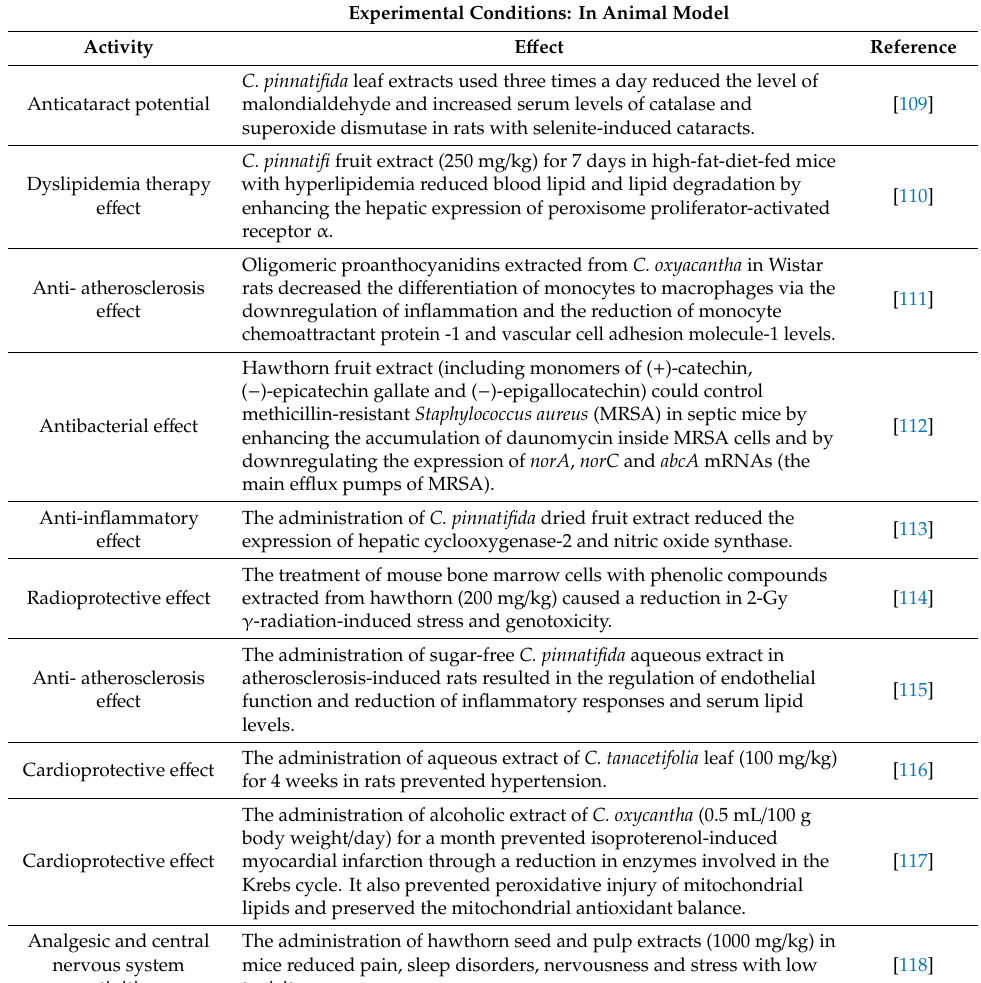
Table 3. The main studies in animals involving